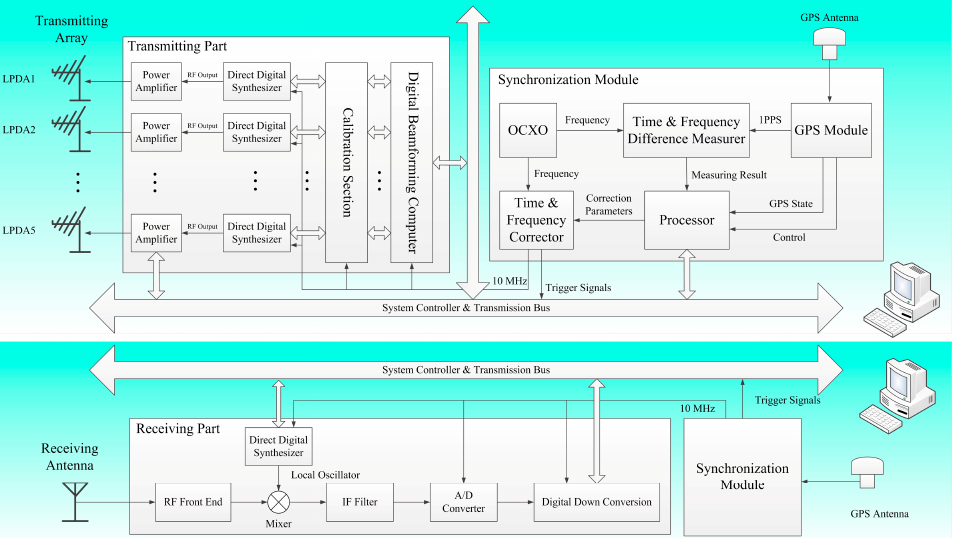
Figure 2. General architecture of WIOBSS-AA. This radio system is composed by the transmitting part, receiving part, and synchronization module.